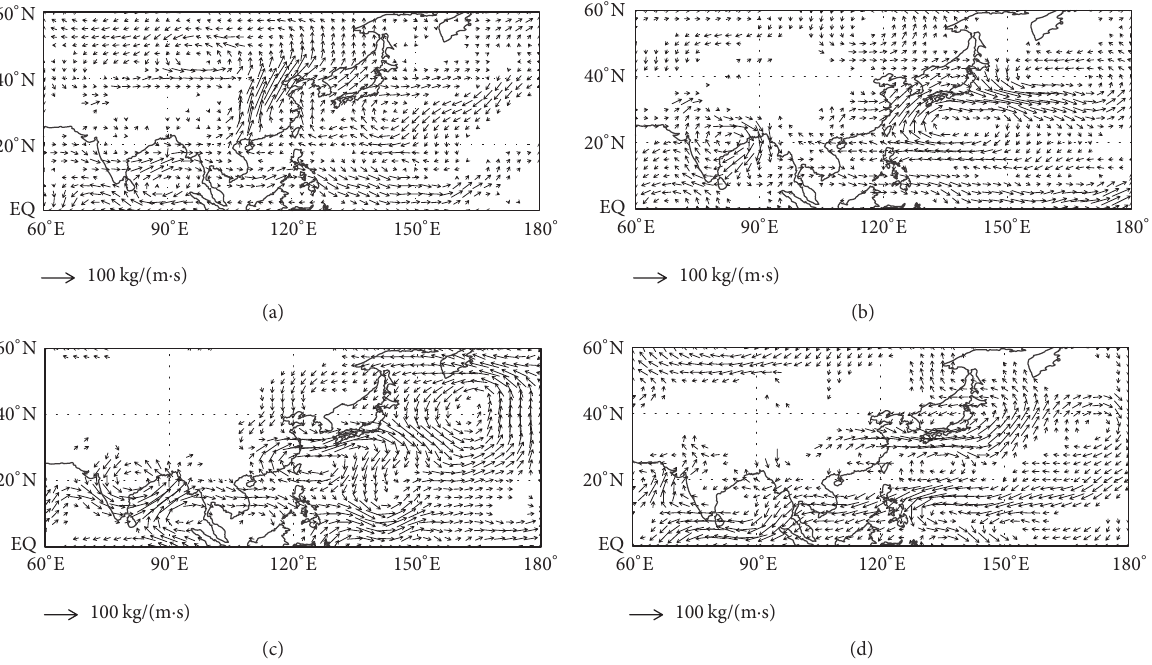
Figure 11: Anomalies of vertically integrated water vapor flux (arrows, units: kg m −1 s −1 ) of the SDNF pattern in the summers of (a) 1963, (b) 1965, (c) 1991, and (d) 2003.